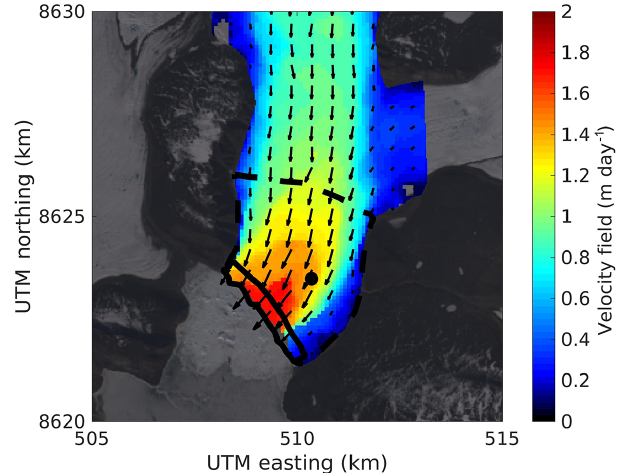
Figure 3. Average velocity field between 14 June and 1 August in- ferred by feature tracking from LANDSAT satellite images. The back dot indicates the position of the borehole. The dashed and con- tinuous lines delimit the enlarged and reduced modelled domains,